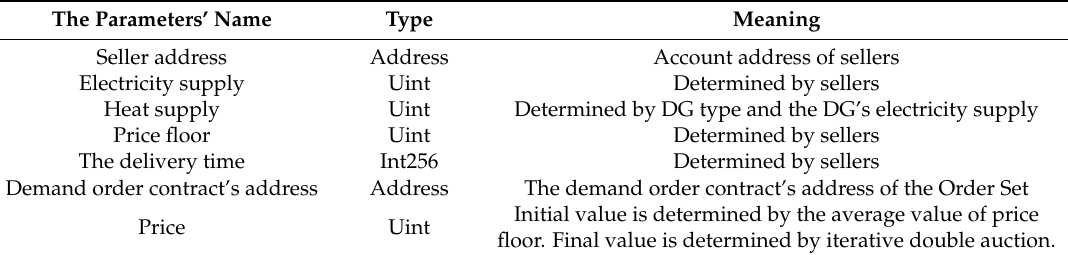
Table 2. Basic elements of a transaction processing contract.